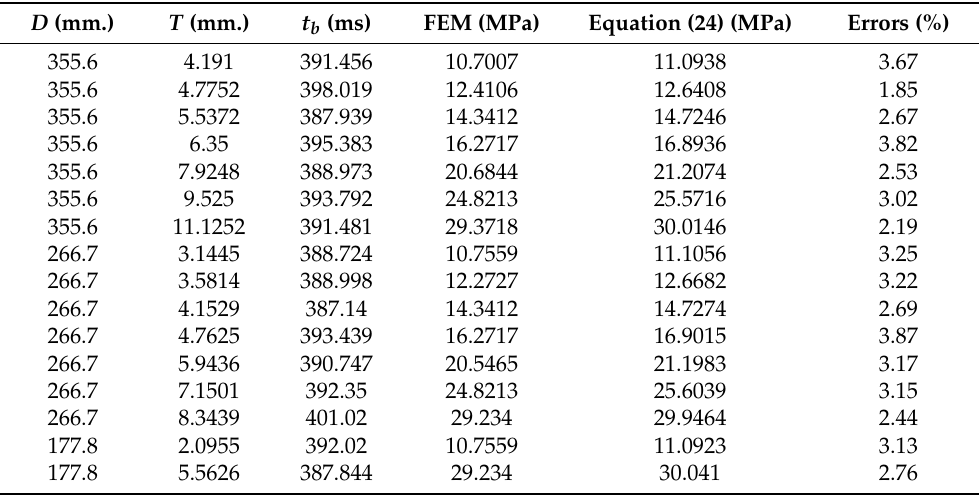
Table A6. Comparisons between the FEM results and the predictions, when t d = 390